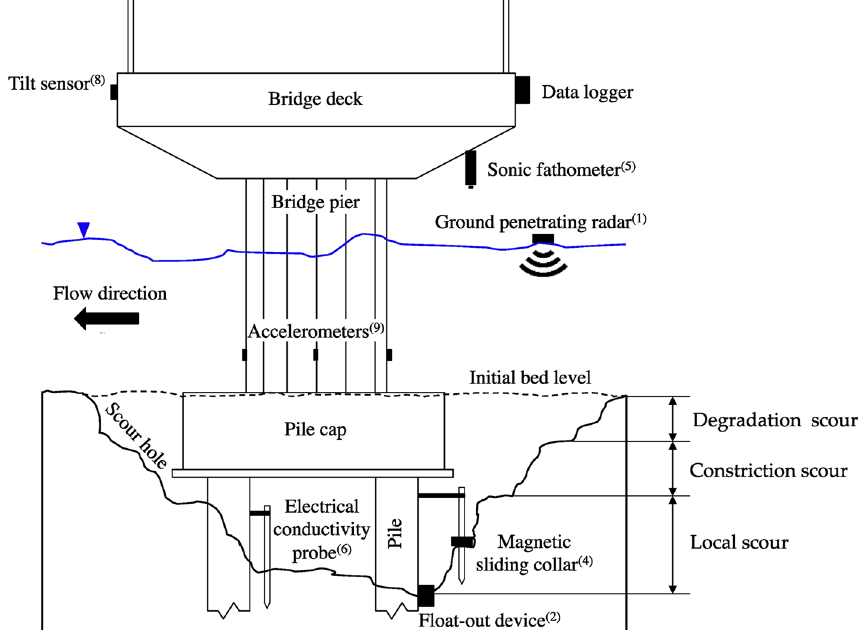
Fig. 5 Devices used to monitor scouring and its progression over time. Figure adapted from Reference (Maroni et al. 2020) with permission from